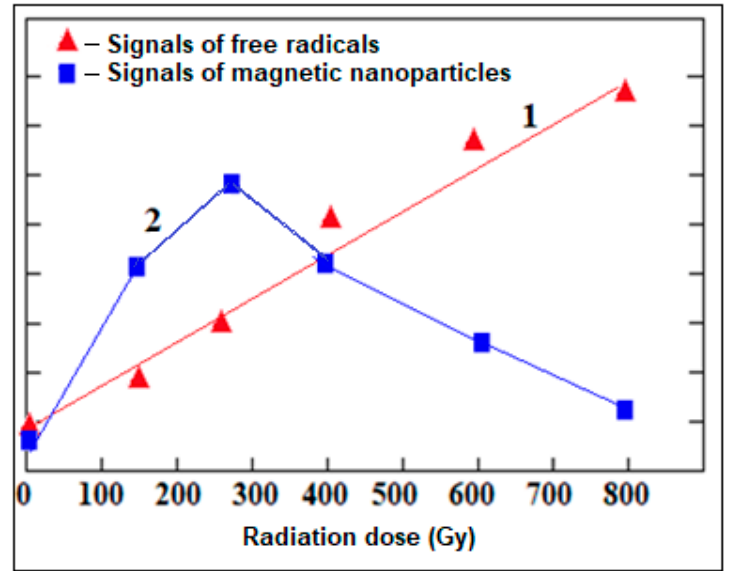
Figure 5. Dependence of the intensities of free radical signals (1) and broad EPR signals characterizing magnetic iron oxide nanoparticles (2) recorded in the body parts of grape snails on the radiation dose.